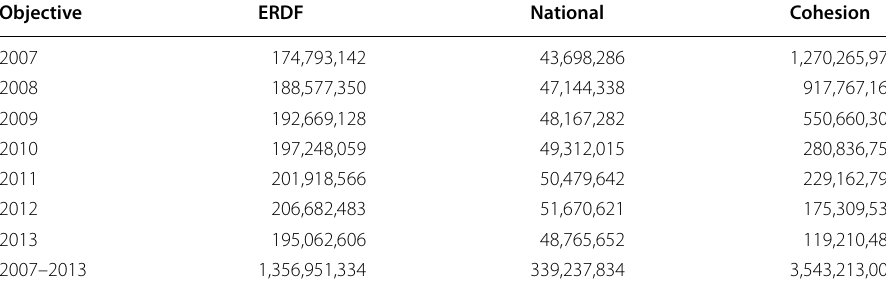
Table 1 National and European funds (in euros). Source Spain: operational program “cohe‑ sion